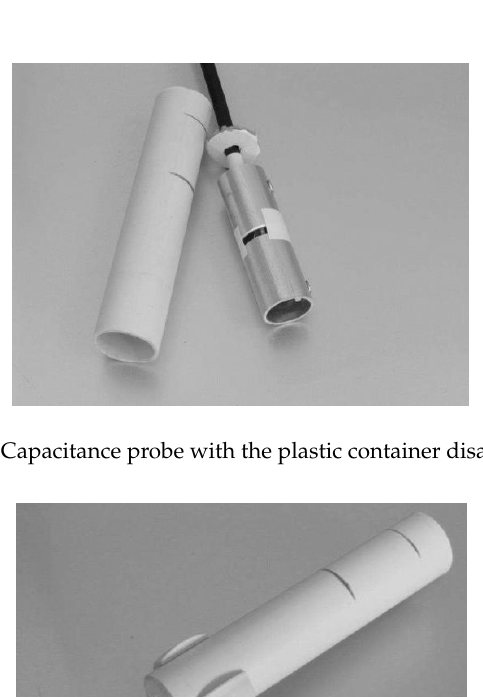
Figure 11. Capacitance probe fully assembled.